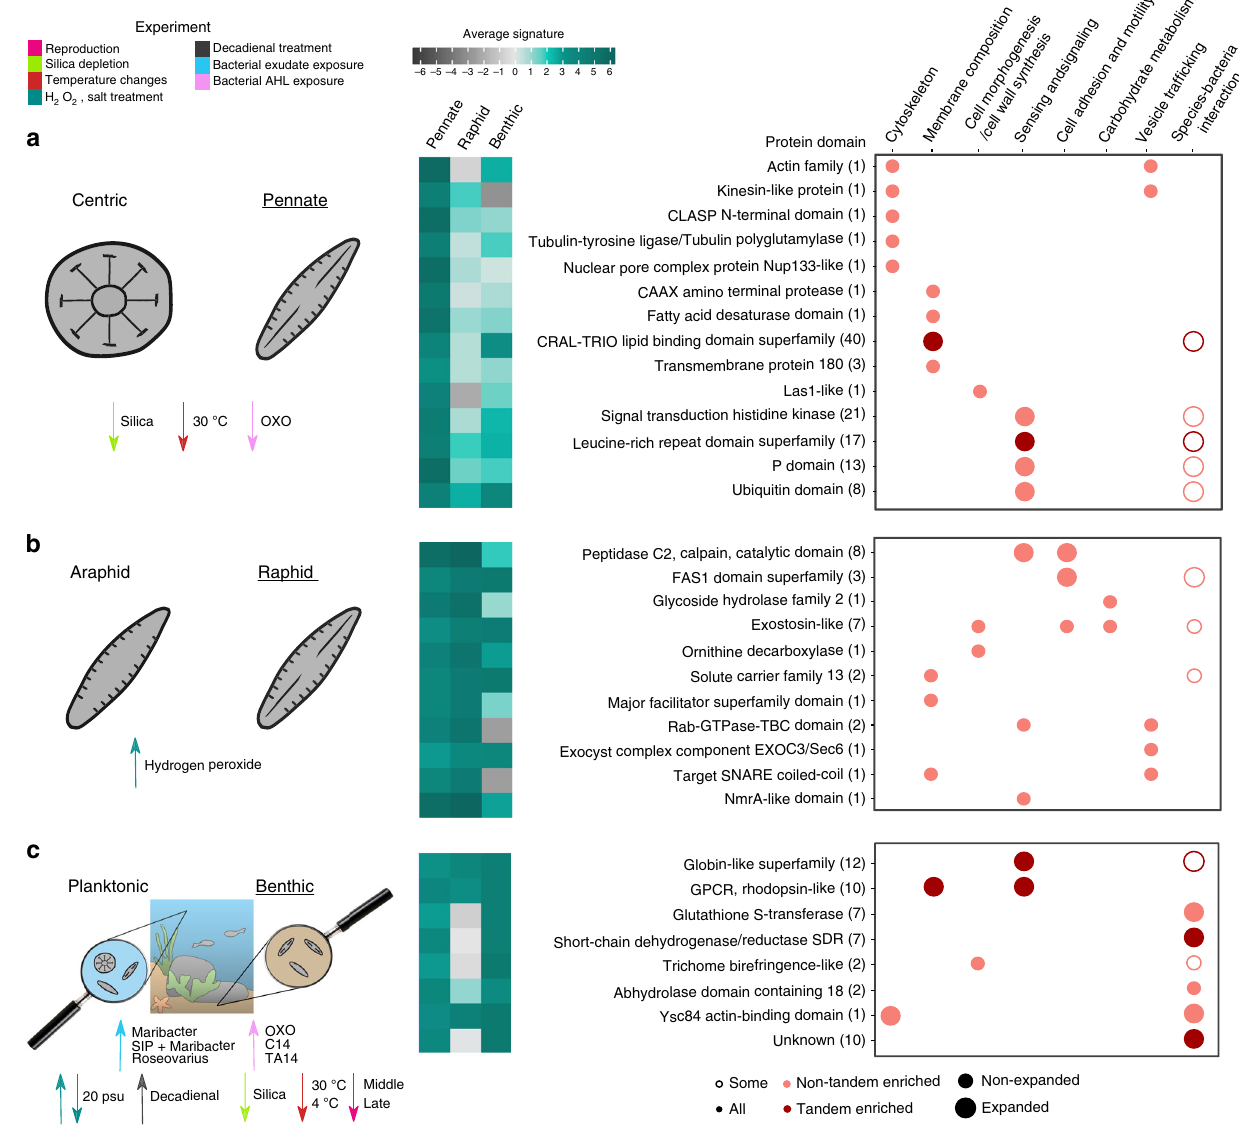
Fig. 5 Selection of signature genes showing strong clade-speci fi c conservation. Signi fi cant enrichment for differential expression in the S. robusta transcriptome of genes showing the speci fi ed signature is highlighted with downward (for downregulation) or upward (for upregulation) arrows colored by experiment. Each row is a protein domain, the number of genes showing the signature, and having that protein domain is indicated in parenthesis. If any of the genes containing one of the highlighted protein domains belong to an expanded and/or tandem-enriched family, this is encoded by the size and color of the circles. The fi ll of the circles indicates if all or some genes with a given protein domain are upregulated during bacterial interaction experiments. The average pennate/raphid/benthic signature per protein domain is highlighted by a color gradient from dark gray ( − 6) to dark green (6). A selection of genes with high pennate signature is shown in panel ( a ), which high raphid signature in panel ( b ) and with high benthic signature in panel ( c ). Source data are provided as a Source Data fi